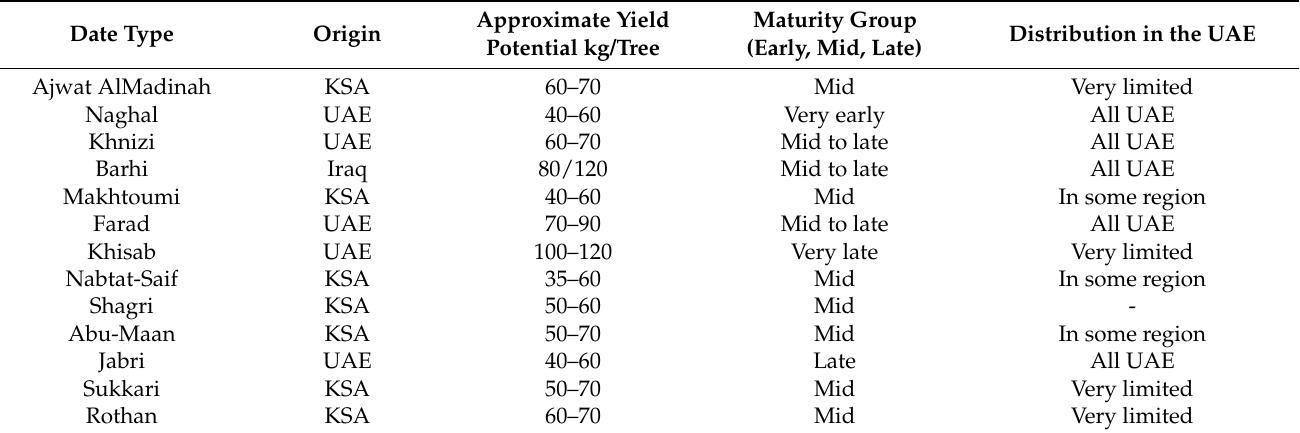
Table 4. Date palm varieties used in the experiment and their origin, approximate potential yield, maturity, and distribution in the UAE.